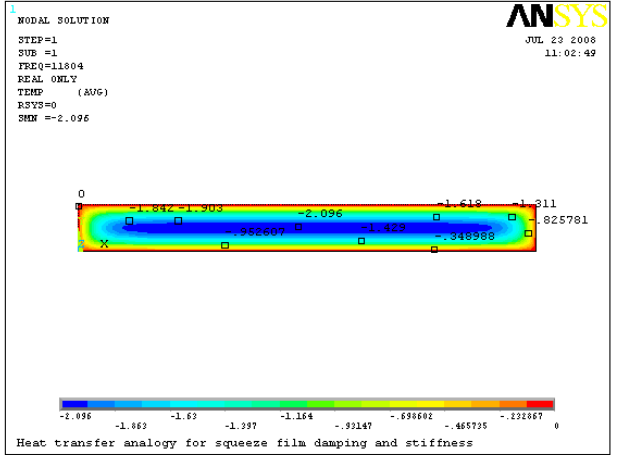
Figure 8. Pressure distributions of the cantilever at the resonant frequency.